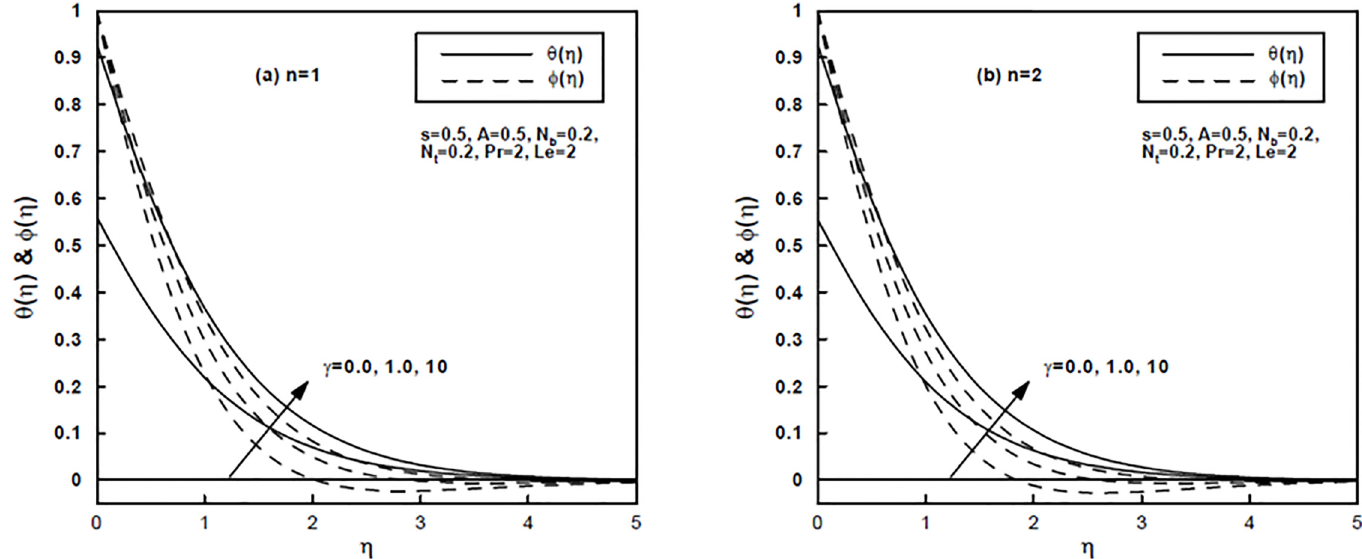
Fig 4. (a,b), The temperature and concentration profiles for different values of the generalized Biot number γ .